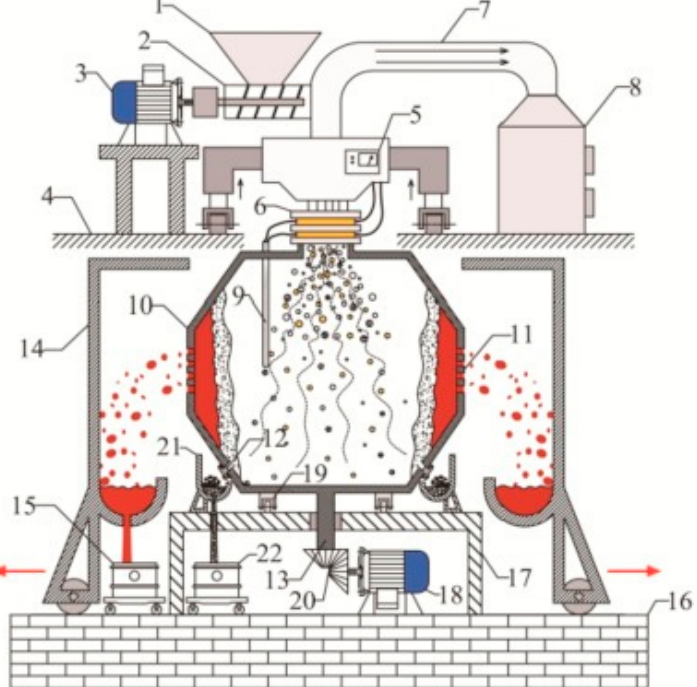
Figure 8. Schematic diagram of a PACT system. Reprinted from [38] with permission from Elsevier 1993. 1—Hopper; 2—spiral feeding rod; 3—motor; 4—high platform; 5—microwave generator; 6—